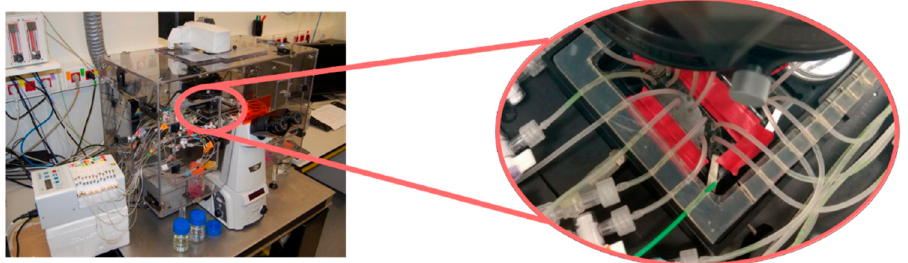
Figure 1. Experimental set ‐ up including a transmission Nikon Eclipse Ti microscope, with a high ‐ resolution monochrome Hamamatsu camera and a specific stage, which allowed the control of tem ‐ perature and environmental conditions to perform cytotoxicity